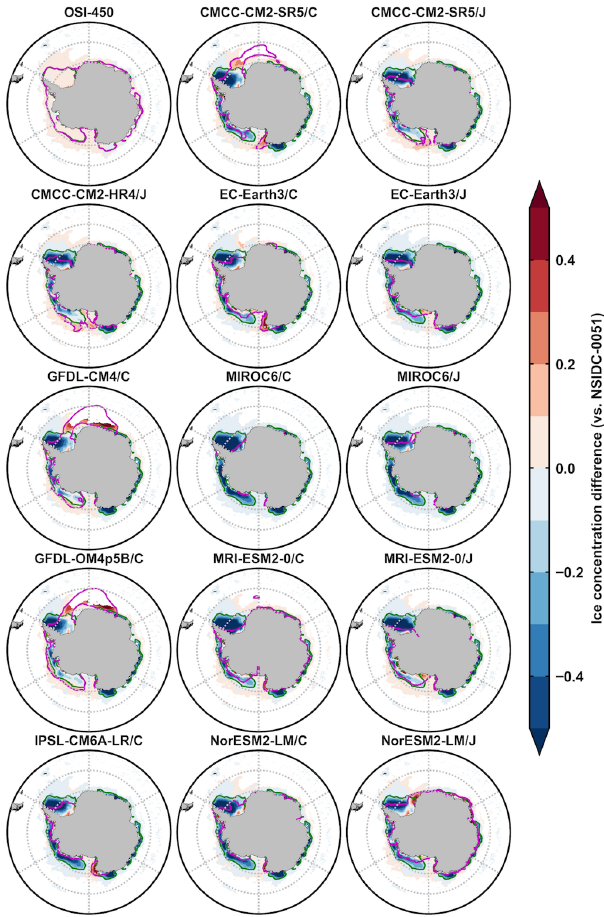
Figure A3. The 1980–2007 February mean Antarctic ice con- centration differences between OSI-450/model outputs and the NSIDC-0051 data (colors), and contours of 15% concentration of the NSIDC-0051 data (green lines) and OSI-450/model out- puts (magenta lines). The second and third columns are from the five OMIP1 and OMIP2 model outputs of CMCC-CM2-SR5, EC- Earth3, MIROC6, MRI-ESM2-0, and NorESM2-LM, respectively.